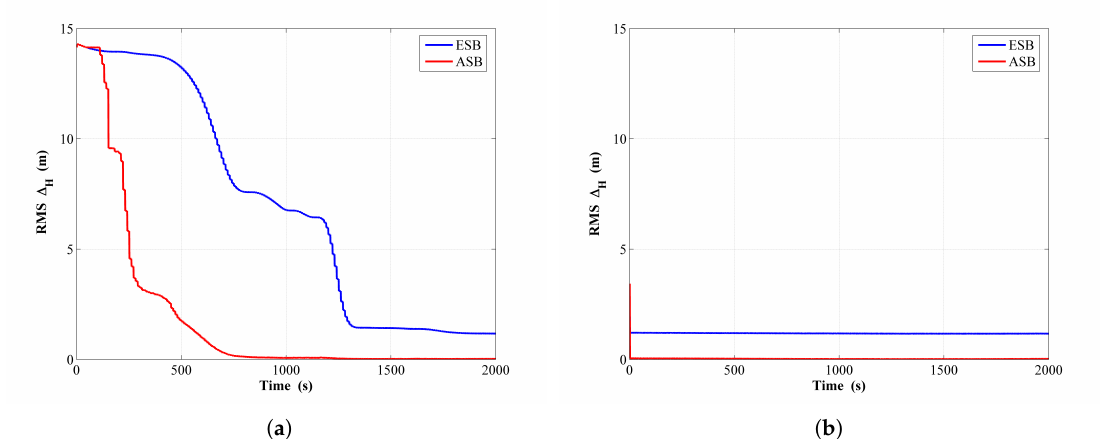
Figure 6. RMS of horizontal distance error comparison between the ESB and the ASB algorithms using simulation data with unknown Q k : ( a ) Filter; ( b ) RTS smoother.